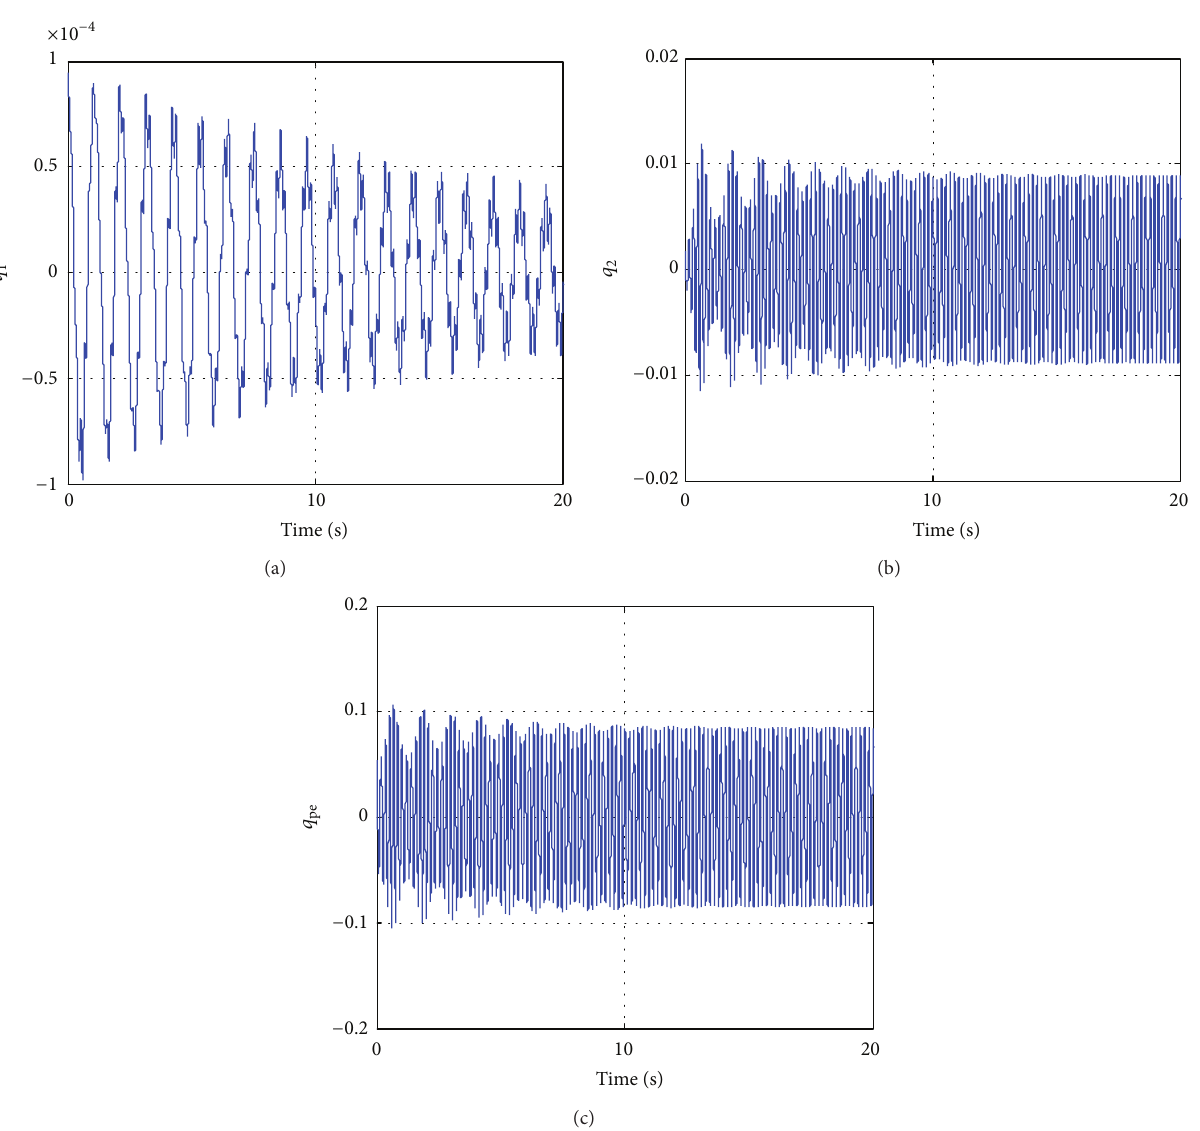
Figure 11: Feedback-linearisation with nonlinear parameter error: response at 97.5 ms −1